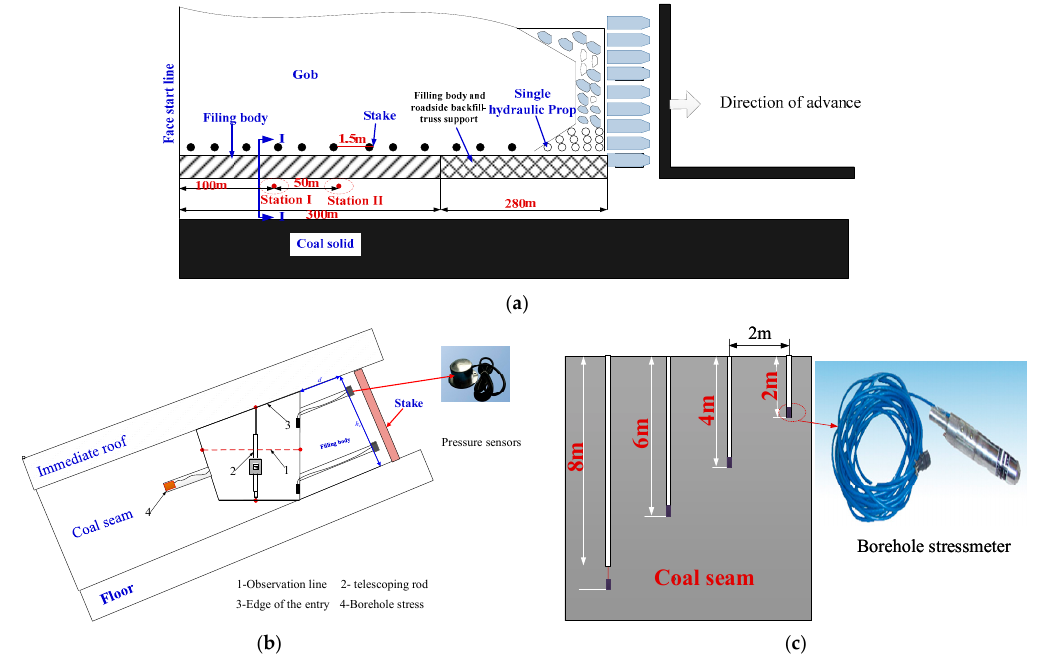
Figure 6. Layout of field monitoring stations: ( a ) layout of observation stations; ( b ) profile of Station I; and ( c ) layout of borehole stress-meters.